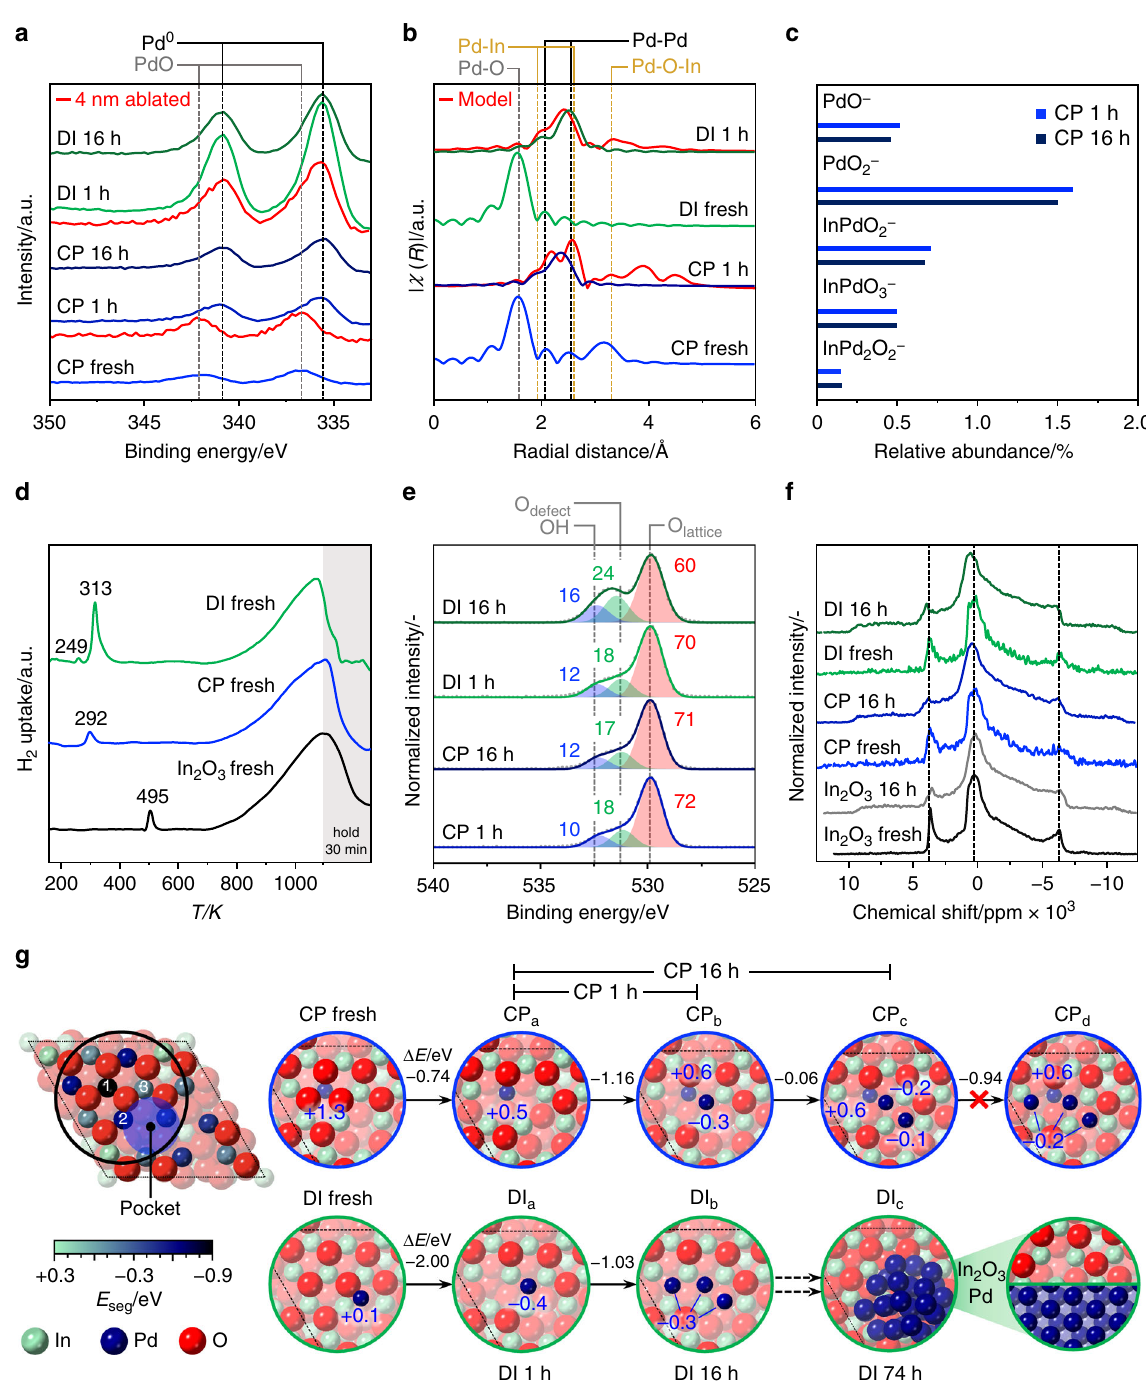
Fig. 3 Experimental and theoretical elucidation of palladium-promoted In 2 O 3 catalysts. a XPS Pd3 d core-level spectra, and b Pd – K-edge EXAFS spectra of the CP and DI catalysts in fresh form and after use in CO 2 hydrogenation for 1 h. EXAFS spectra simulated for the latter are added in red. The dashed lines mark expected positions of signals of the species indicated 52 – 54 . c Abundance of Pd-containing fragments emitted from the surface of used CP and DI materials in TOF-SIMS analysis. d H 2 -TPR pro fi les at 5 MPa of the fresh CP and DI catalysts with In 2 O 3 as a reference. e XPS O1 s core-level spectra of CP and DI catalysts after use for 1 and 16 h. The contribution of lattice oxygen, oxygen close to a defect, and oxygen in a hydroxyl group retrieved from deconvolution are marked in red, green, and blue, respectively, and labeled with their relative abundance in %. f In 115 NMR spectra collected for pure In 2 O 3 and the CP and DI catalysts in fresh form and after use for 16 h. g (left) Structure of a regularly terminated In 2 O 3 (111) surface featuring, owing to the strong anisotropy, a depression (pocket) where Pd atoms preferentially accommodate in the fresh DI catalyst. The coloring of In atoms at the surface represents the energy associated with their replacement by palladium ( E seg , in eV), which takes place upon CP. 1 – 3 mark the lattice positions most preferred by the promoter. (right) Initial palladium-promoted In 2 O 3 (111) surface models for the CP and DI catalysts and their evolution to account for structural modi fi cations occurring upon their use for in the reaction. The energy difference between states for each transition ( Δ E , in eV) and the Bader charges of the Pd atoms ( q B in |e ‒ |) are indicated in blue. Atoms are shaded with a progressively lighter color upon increasing distance from the surface towards the